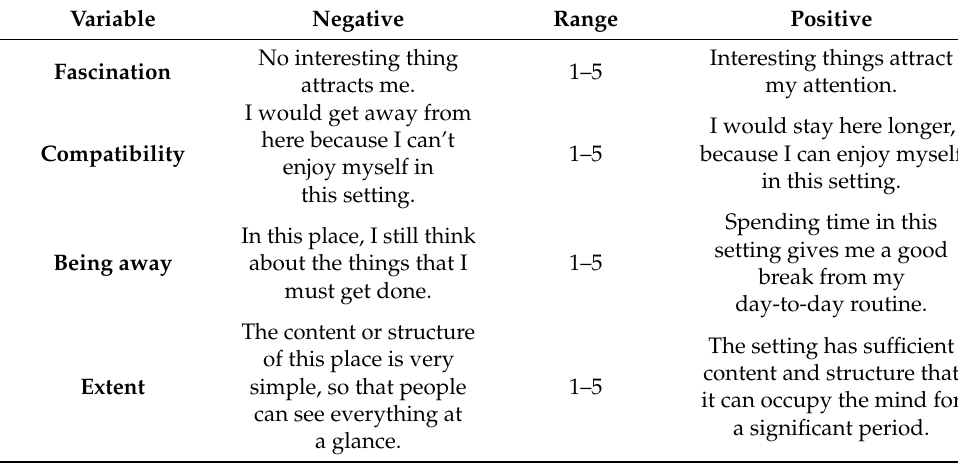
Table 2. Short-version Revised Restoration Scale on mental